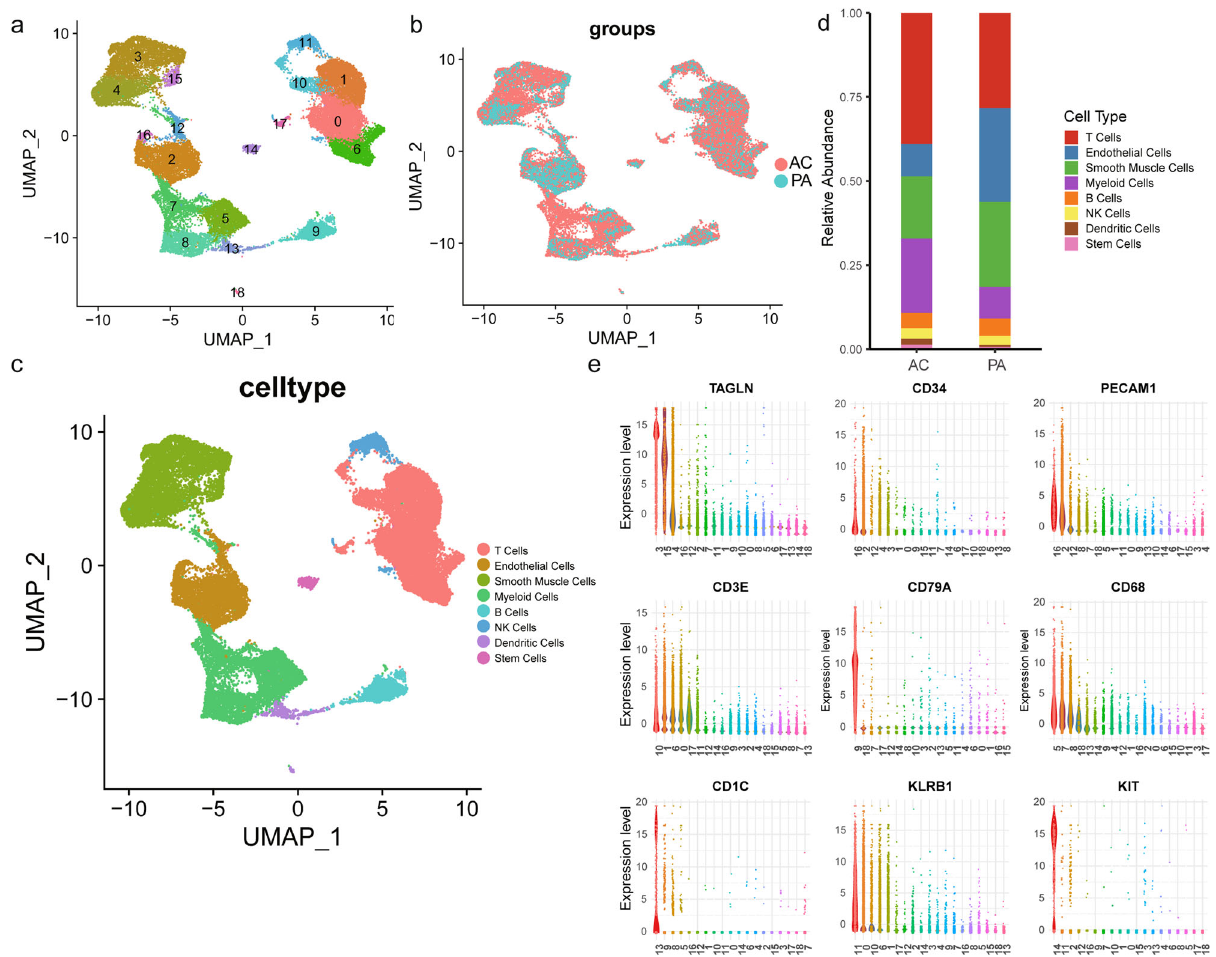
Fig. 1 Single-cell RNA sequencing (scRNA-seq) analysis reveals cellular heterogeneity of proximal adjacent (PA) and calci fi ed atherosclerotic core (AC) portions of plaques. UMAP clustering plots showing a 19 color-coded cell clusters, b different groups, and c 8 cell populations of a total of 35,021 individual cells based on gene expression. d Bar chart of the relative frequency of different cell types in PA and AC groups. e Violin plots of signature genes of different cell type con fi rmed cluster